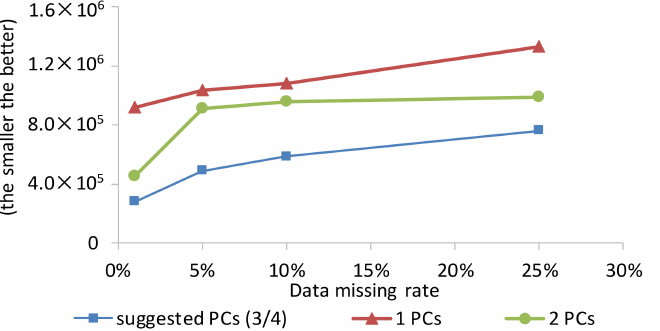
Figure 10. The accurate performance of data imputation method with various settings and different missing rate